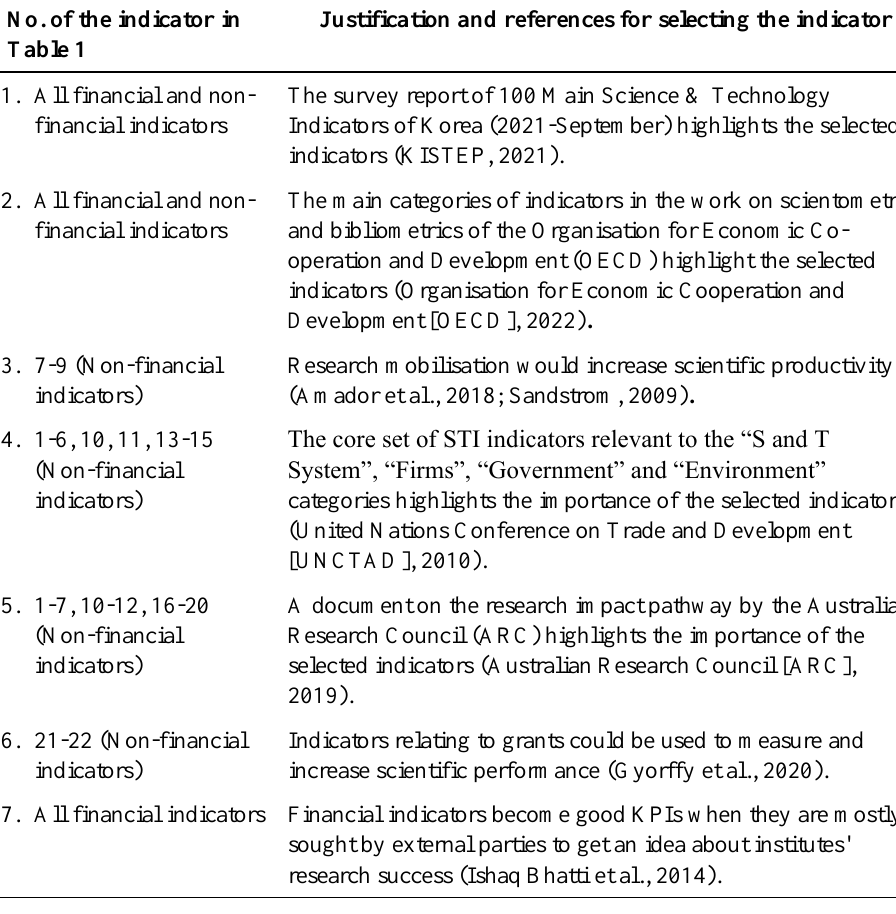
Table 2: Justification for Selection of Indicators for Proposed Model KPI Index No. of the indicator